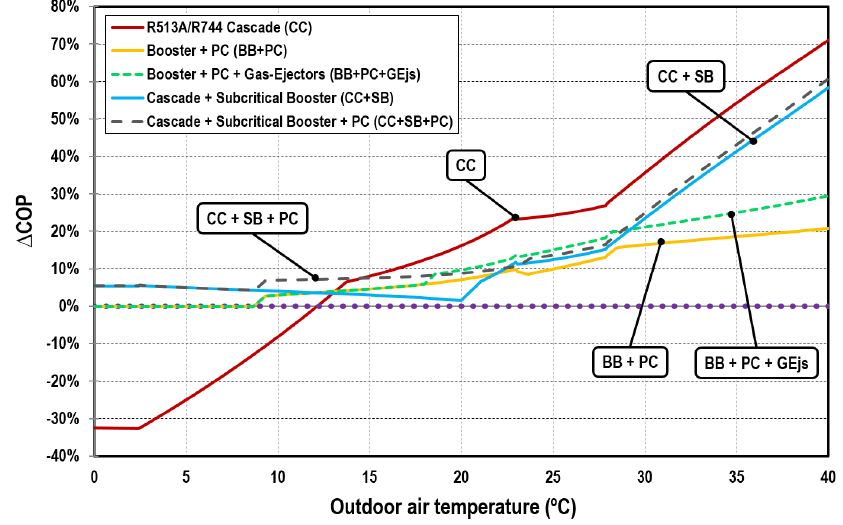
Figure 11. COP increment of each system with respect to R744 basic booster. Table 2. COP variation of each architecture compared with the R513A/R744 cascade (CC) and R744 basic booster